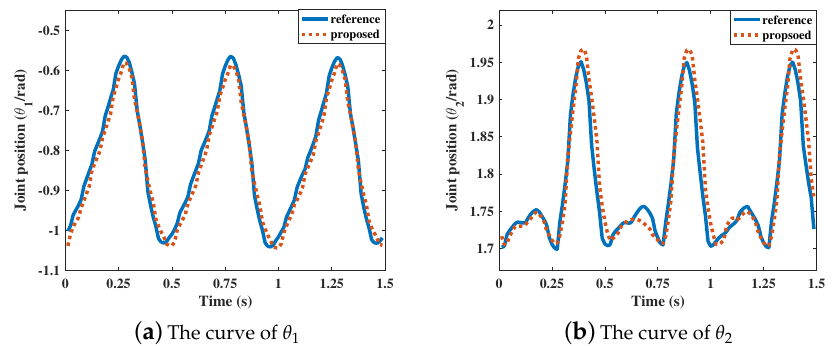
Figure 14. Joint positions of the RF leg in the SCalf prototype